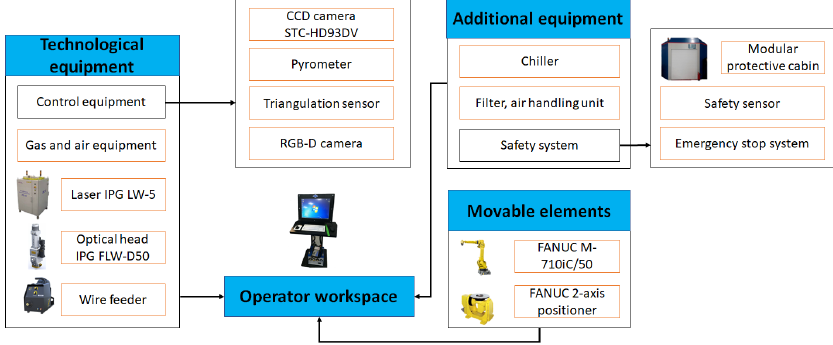
Figure 5. The structural scheme of a laser robotic welding complex (© 2020 IEEE [30]).